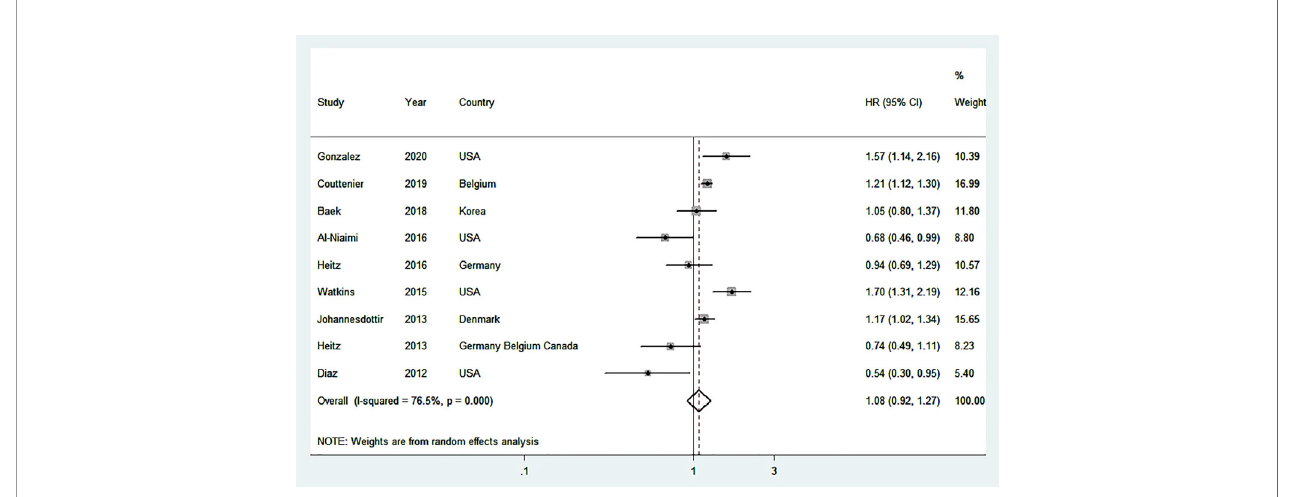
FIGURE 2 | Forest plot (random-effects model) of the association between post-diagnostic beta blocker use and total mortality of OC patients. Squares indicate study-speci fi c hazard ratios (HR), where the size of the square re fl ects the study-speci fi c statistical weight; horizontal lines indicate the 95% con fi dence interval (CI); diamonds denote the summary hazard ratio with 95%